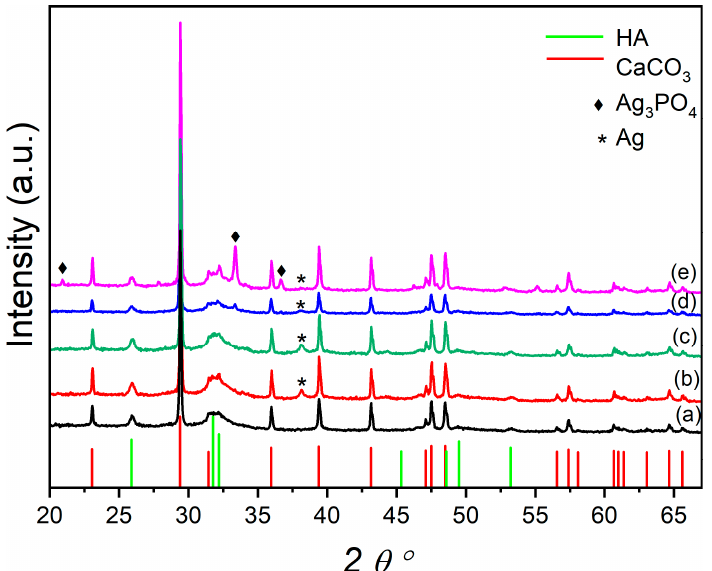
Figure 1. XRD pattern of OMP (a) compared with the OMP@silver composites: US50B (b), US100B (c), US50C (d), and US100C (e). Pattern lines: CaCO 3 (COD ID: 9015390), red lines; HA (COD ID: 9011097), green lines; Ag 3 PO 4 (COD ID: 2106404), ; Ag (COD ID: 9008459) *.